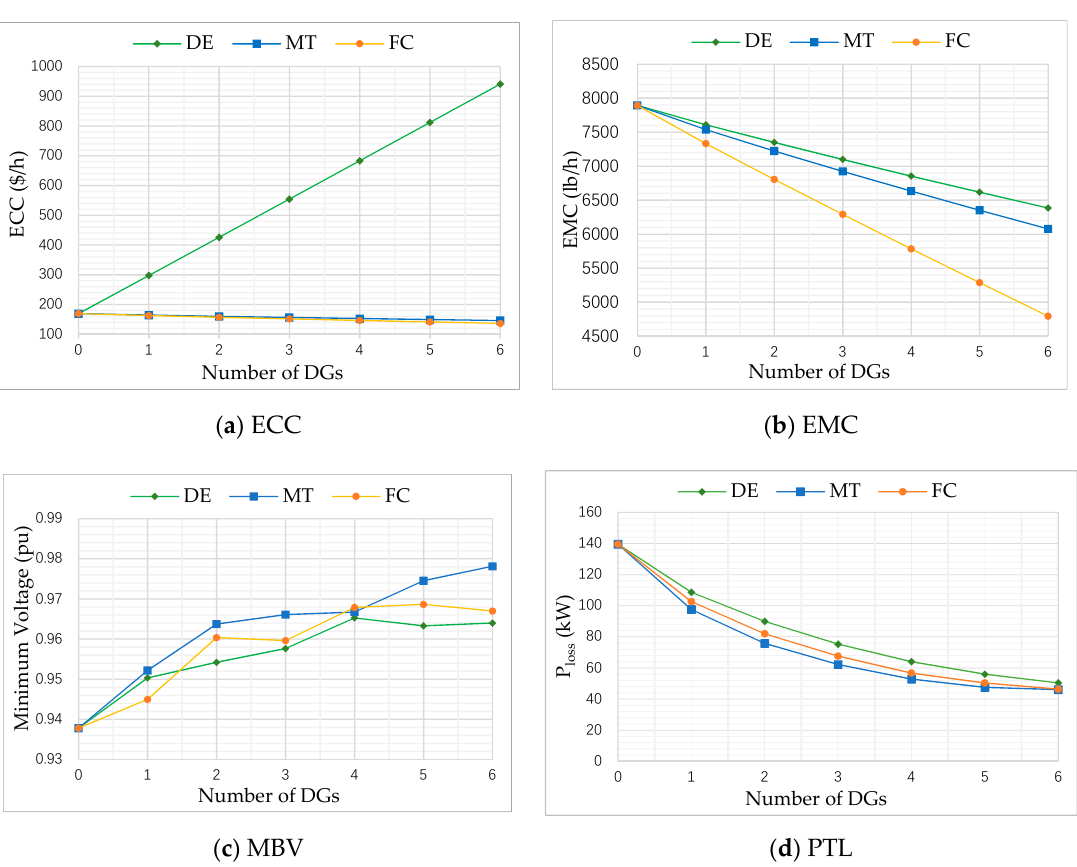
Figure 2. ECC, emission cost (EMC), minimum bus voltage (MBV), and power transmission loss (PTL) changing curve with the increasing number of DGs.